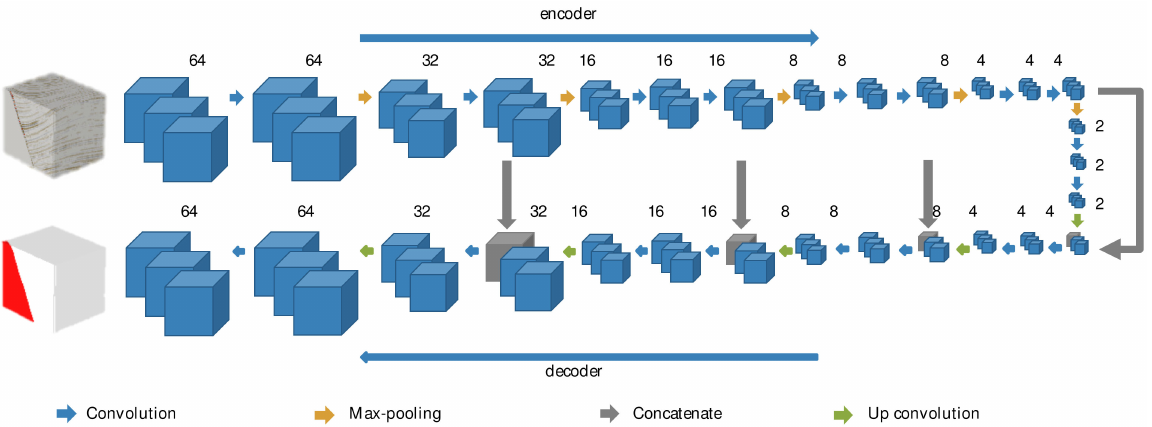
Figure 7. The modified U-Net architecture: decreased number of filters on encoder path and increased number of filters on decoder